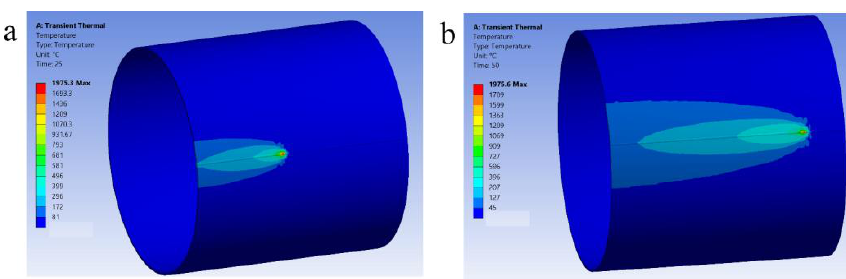
Fig. 10. Temperature profile during longitudinal welding at different time frames